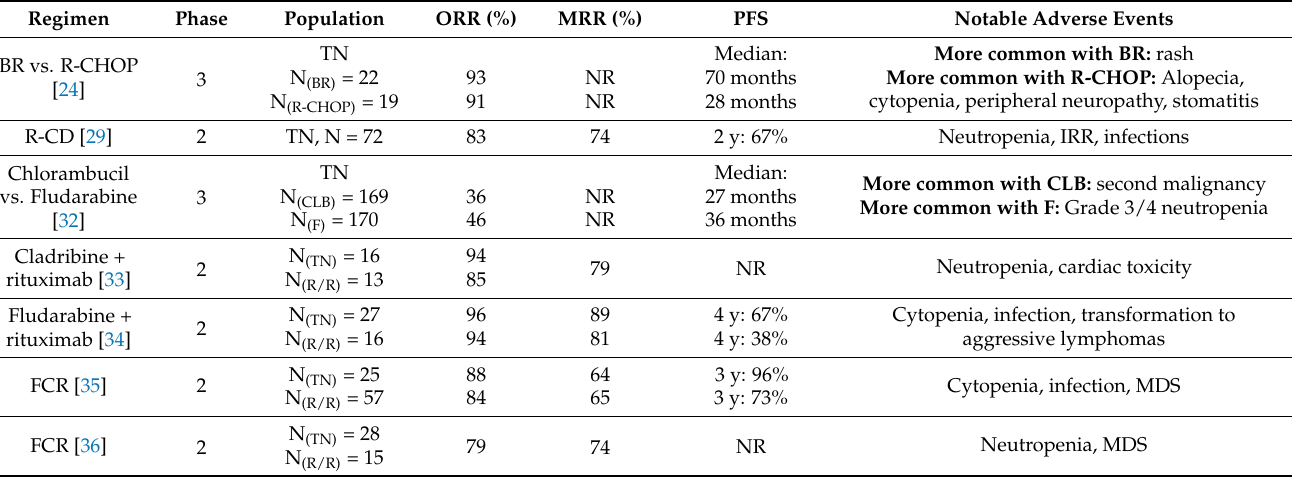
Table 1. Notable clinical trials evaluating chemoimmunotherapy in Waldenström